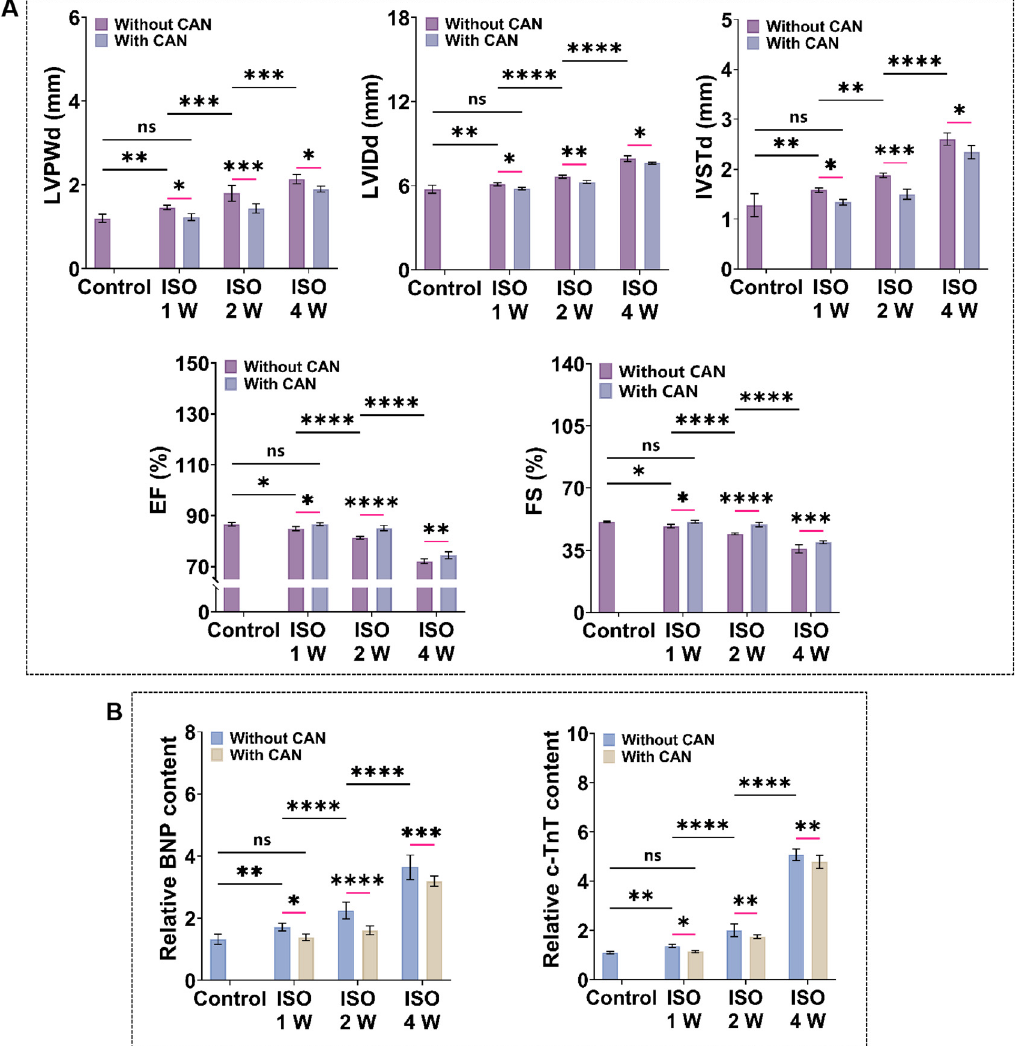
Figure 2. Characterization results of cardiac function and myocardial injury markers in myocardial fibrosis rats without and with CAN treatment. ( A ) Statistical histogram of echocardiographic statistics of myocardial fibrosis rats without and with CAN treatment ( n = 5). ( B ) Statistical histogram of relative contents of BNP and c-TnT in plasma of myocardial fibrosis rats without and with CAN treatment ( n = 5). Data are shown as means ± SEM. ns, no significant difference, * p < 0.05, ** p < 0.01, *** p < 0.001, and **** p < 0.0001 determined by two-way ANOVA.